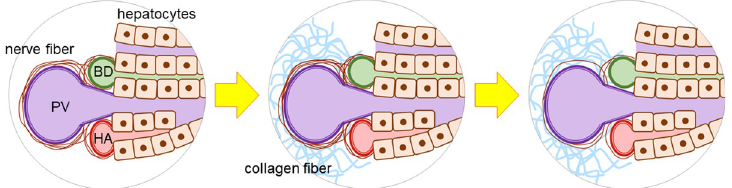
Fig 7. Decrease of intrahepatic nerve fibers associated with fibrosis. During the hepatic fibrosis progression, intrahepatic nerve fibers are also damaged by physical mechanism, resulting in regression of fibers. PV: portal vein, BD: bile duct, HA: hepatic